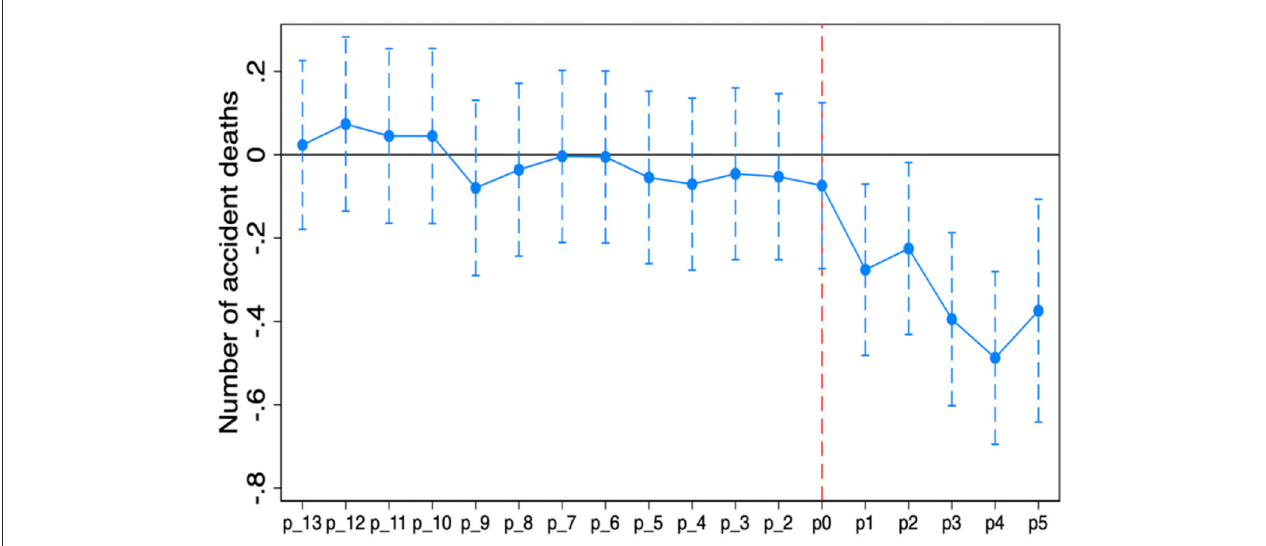
FIGURE2 The result of dynamic effects (Number of accident deaths).